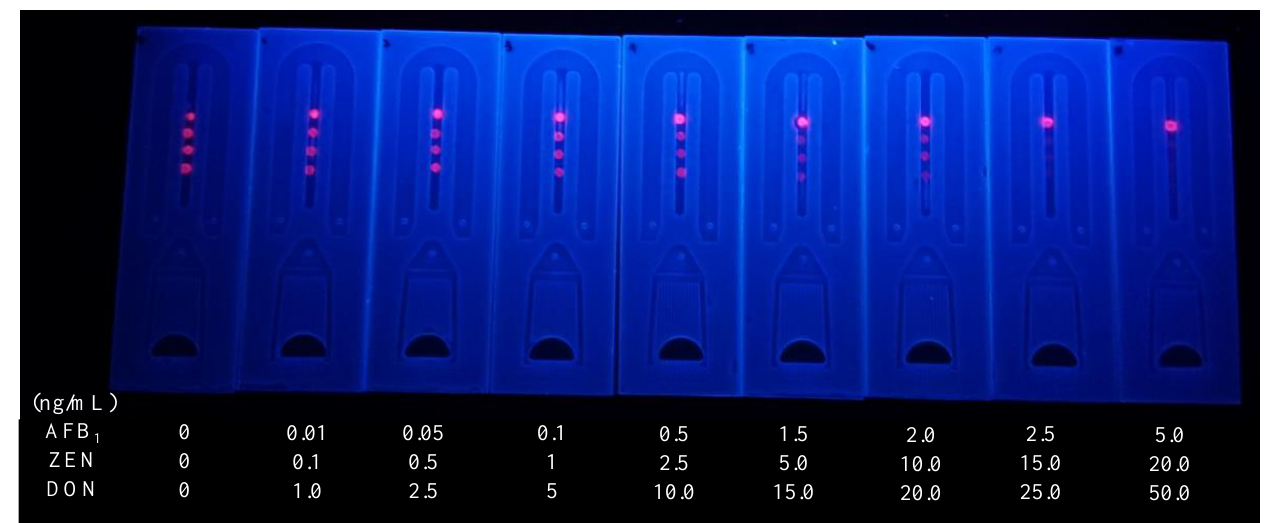
Figure 9. The Sensitivity analysis of Microfluidics: ( a ) AFB 1 ; ( b ) ZEN; ( c ) DON. Samples were collected by Winsor Food Group Co., Ltd.; these samples included both positive and negative samples. As shown in Table 3, after sample pretreatment, the AFB1, ZEN, and DON sample linear range was 0.05~2.2 µ g/kg, 1.45~375.75 µ g/kg, and 11.1~124.2 µ g/kg (samples exceeding the linear range were diluted and tested).